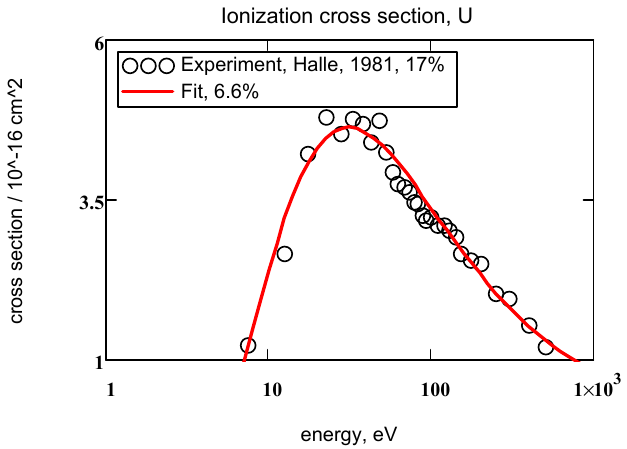
Figure 8. Experiment [30] and the result of approximation by the one − term Formula (6) of the ion- ization cross section of uranium atoms with a mean square relative error of 6.6%.